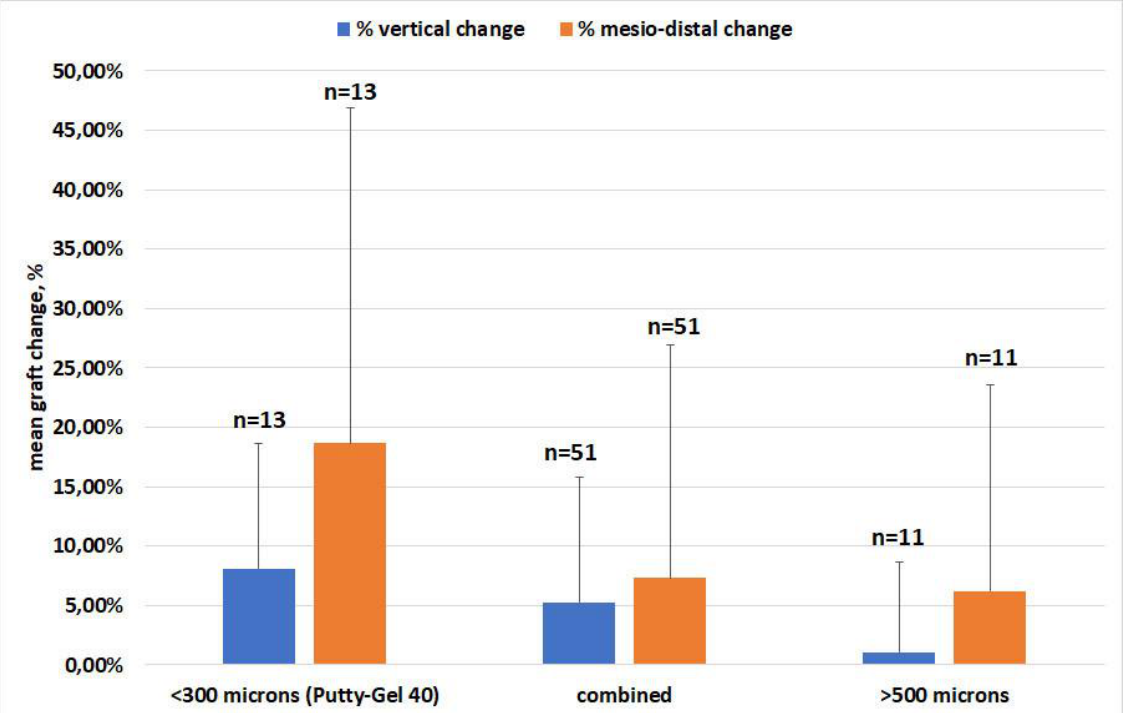
Figure 4. Mean vertical and mesiodistal changes, with standard deviations, for the three groups of grafting biomaterials. The biomaterials are grouped according to the granule size, as described in the text. Data are expressed in percentage of change, respective to postoperative values. The graft was the unit of analysis. The number of cases per groups is also indicated.